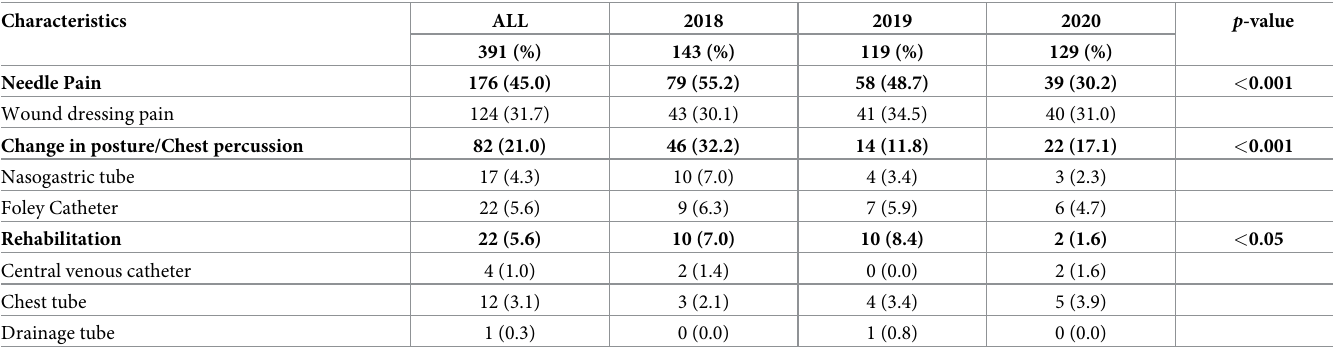
Table 3. The changes of care-related pain with severity � 4 and duration � 4 h. Characteristics